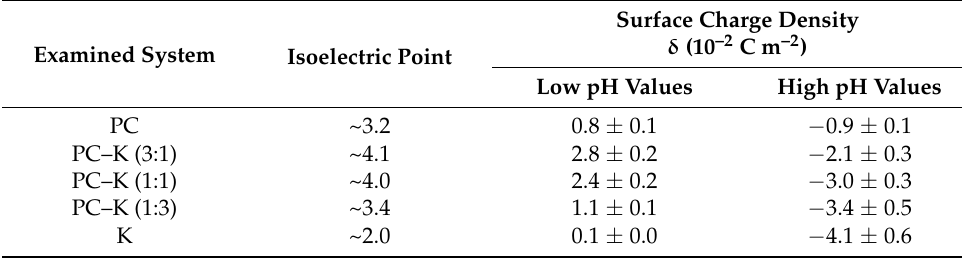
Table 2. The surface charge densities and isoelectric points for the PC–K